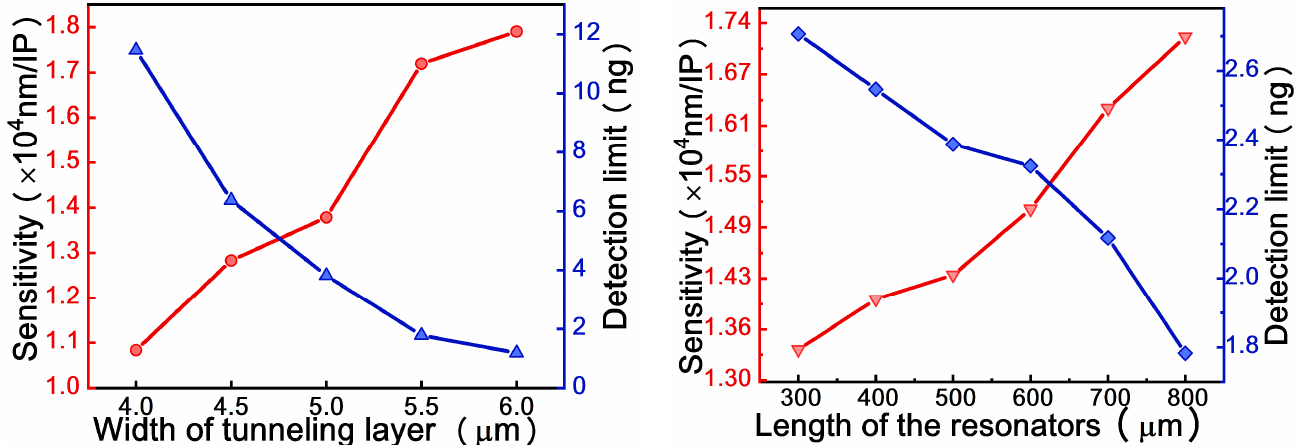
Figure 9. Effect of the width of tunneling layer (left panel) and the length of the resonators (right panel) on the detection limit (blue line) and the sensitivity (red line) near the exceptional point (EP).